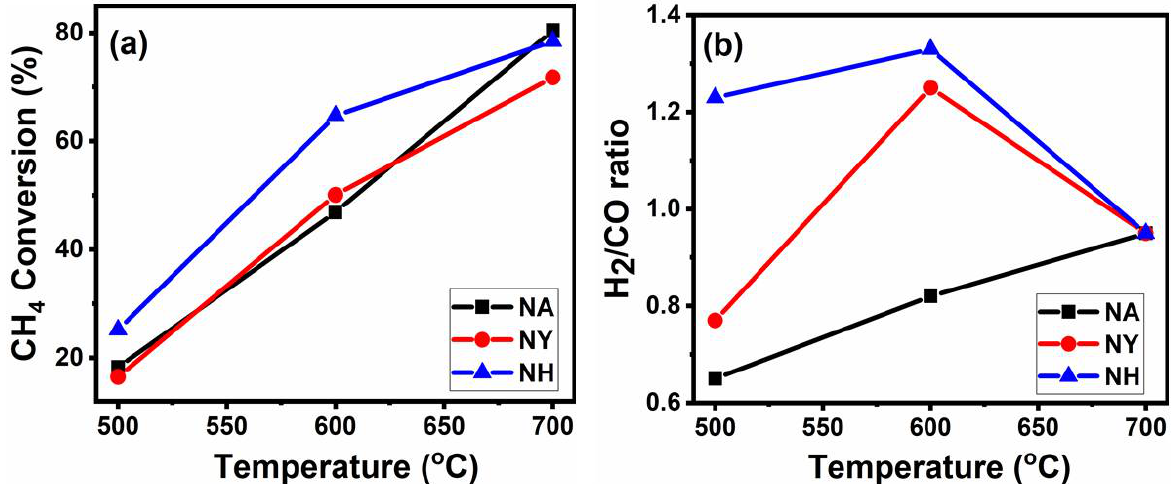
Figure 1. ( a ) CH 4 and ( b ) CO 2 conversion versus time on stream for Ni supported on alumina (NA), Ni supported on Y-zeolite (NY), and Ni supported on H-ZSM-5 (NH) catalysts.